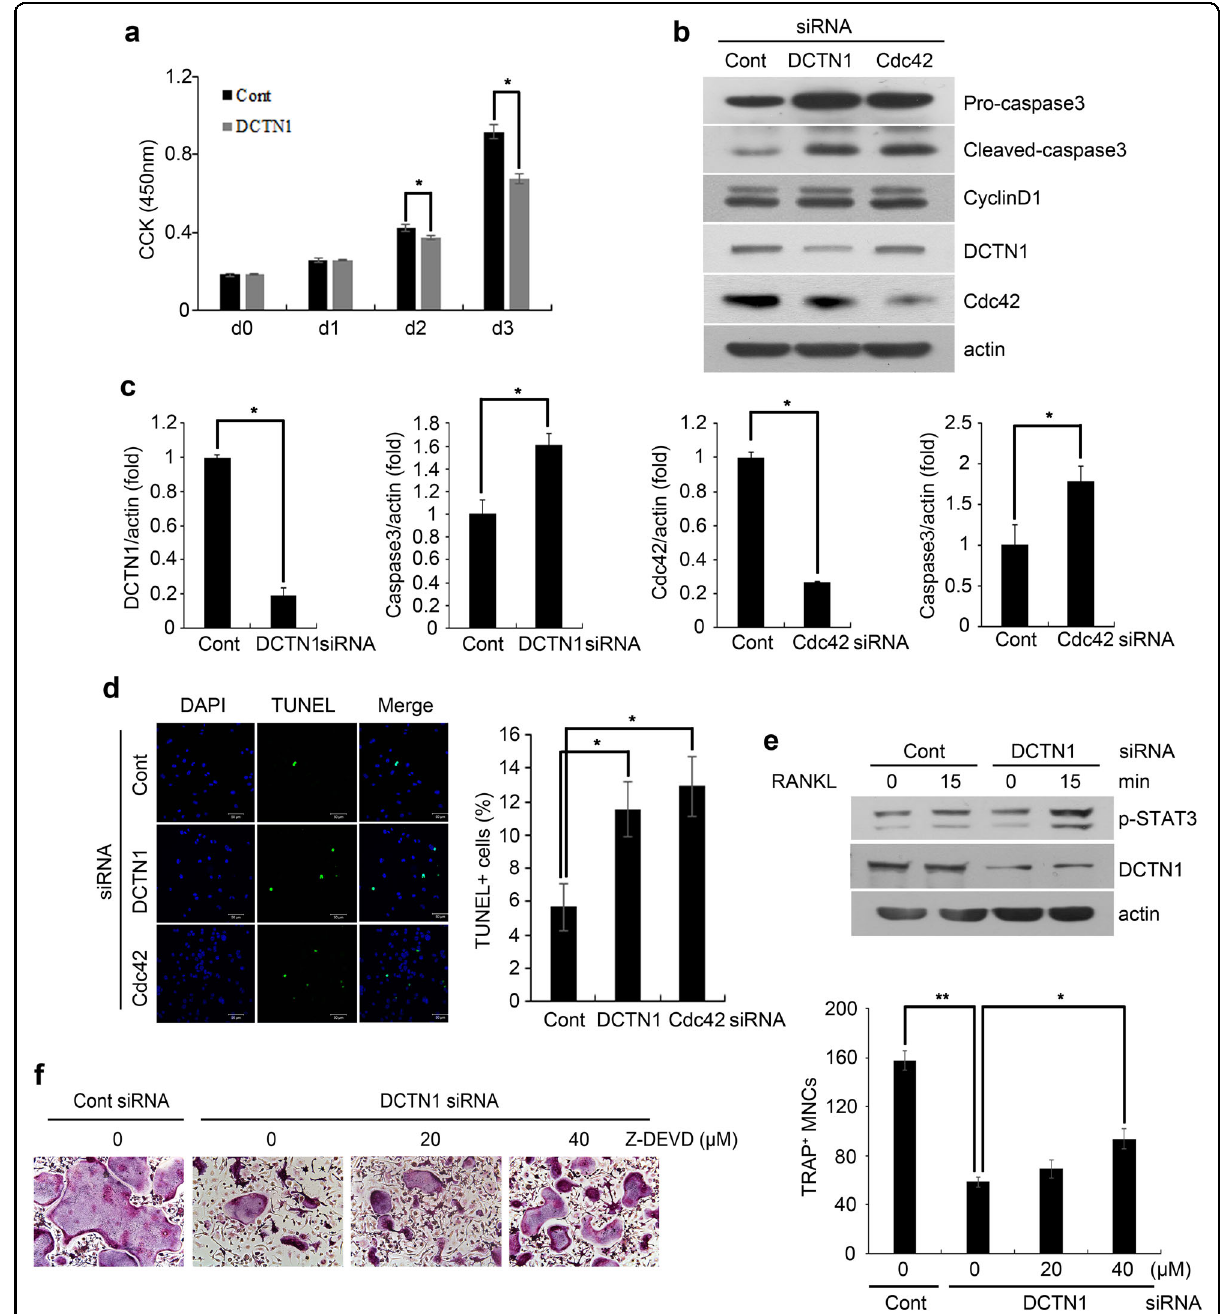
Fig. 5 DCTN1 de fi ciency induces the apoptosis of OC precursors. a BMMs transfected with control or DCTN1 siRNA were cultured in ODM for the indicated number of days. A cell proliferation assay was performed with a CCK kit. b , c BMMs were transfected with control, DCTN1, or Cdc42 siRNA and cultured in ODM for 2 days. The protein and mRNA levels of caspase-3, cyclin D1, DCTN1, and Cdc42 were detected by western blotting and real- time PCR, respectively. d BMMs transfected with control, DCTN1, or Cdc42 siRNA were cultured in ODM for 2 days. The cells were subjected to the TUNEL assay, and TUNEL-positive cells were counted. e BMMs were transfected with control or DCTN1 siRNA. After serum starvation for 6 h, the cells were treated with RANKL (400 ng/ml) for 15 min. The phosphorylation of STAT3 was determined by western blotting. f BMMs transfected with siRNA were cultured in ODM for 4 days with Z-DEVD-FMD or vehicle during the fi rst 48 h. TRAP-positive multinucleated cells were counted. * p < 0.05, ** p < 0.005 compared with